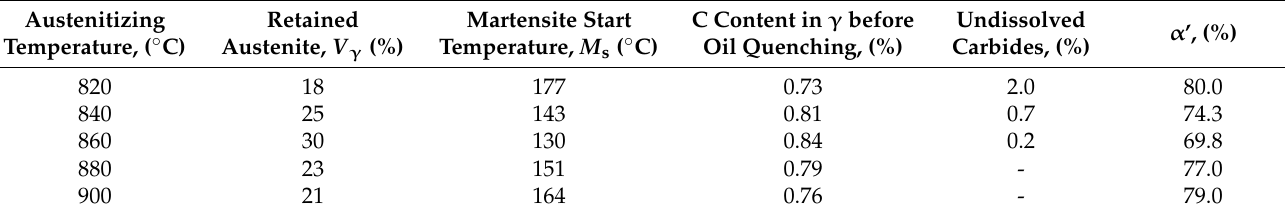
Table 2. Microstructural constituents in the near-surface carburized case of the